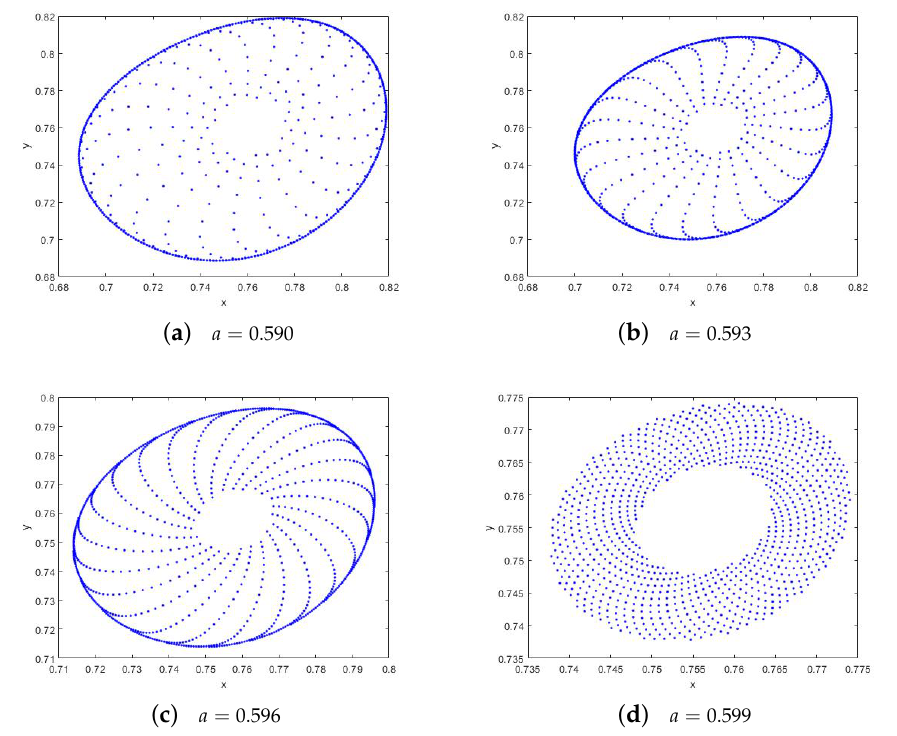
Figure 4. Phase portraits for system (10) with b = 1.4 and different a when the initial value ( x 0 , y 0 ) = ( 0.75,0.75 ) is inside the closed